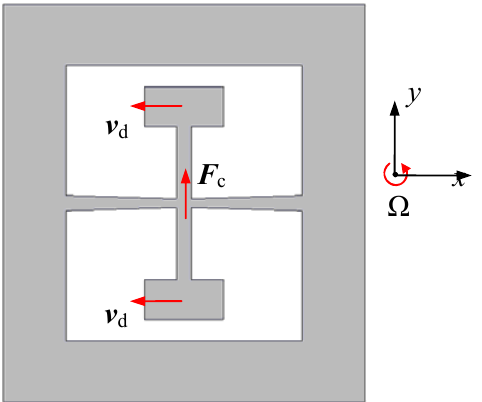
Figure 2. Schematic diagram of the working